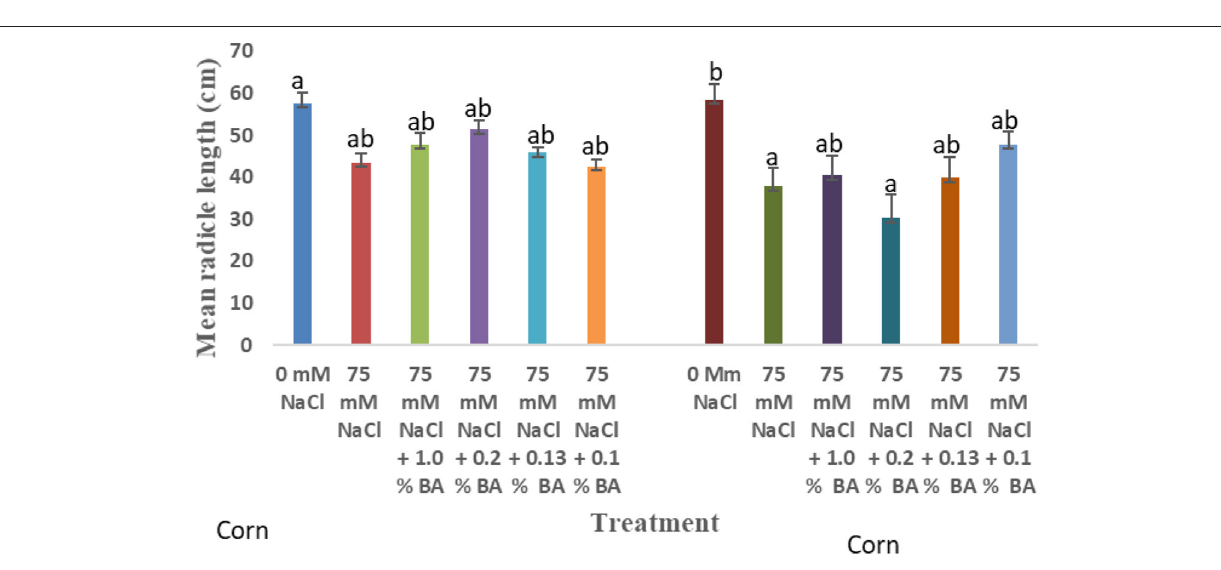
mean percentage germination of soybean grown under optimal conditions (93.75%), which was also the highest. There was no significant difference in the effect of the treatments on mean percentage germination. The lowest mean percentage germination (95.75%) was observed in soybean treated with 0.1% M13. At 24 h, mean percentage germination was significantly 75 mM NaCl, by 53.3% compared to the mean percentage germination of soybean under optimal conditions. There was no significant difference between mean percentage germination of soybean treated with microbial derived compounds and the